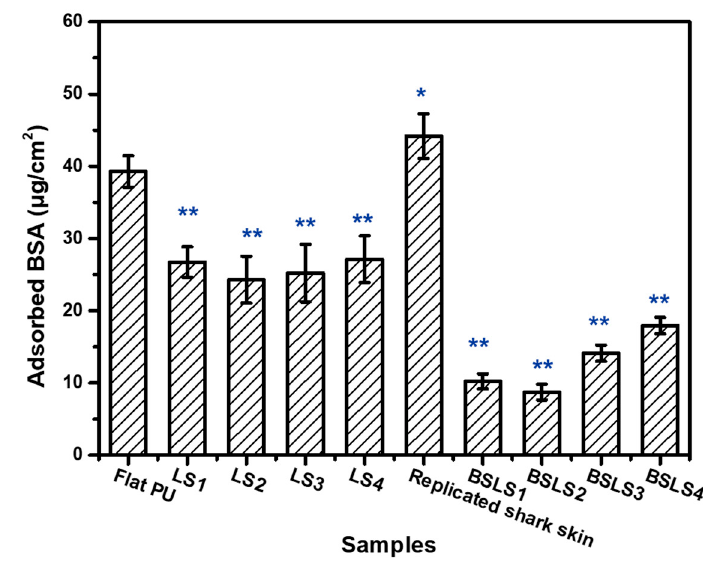
Figure 8. The amount of adsorbed BSA on the surface measured by the Braford method. *P < 0.05 different and **P < 0.01 significantly different from adsorbed BSA measured on flat PU by One-way ANOVA.